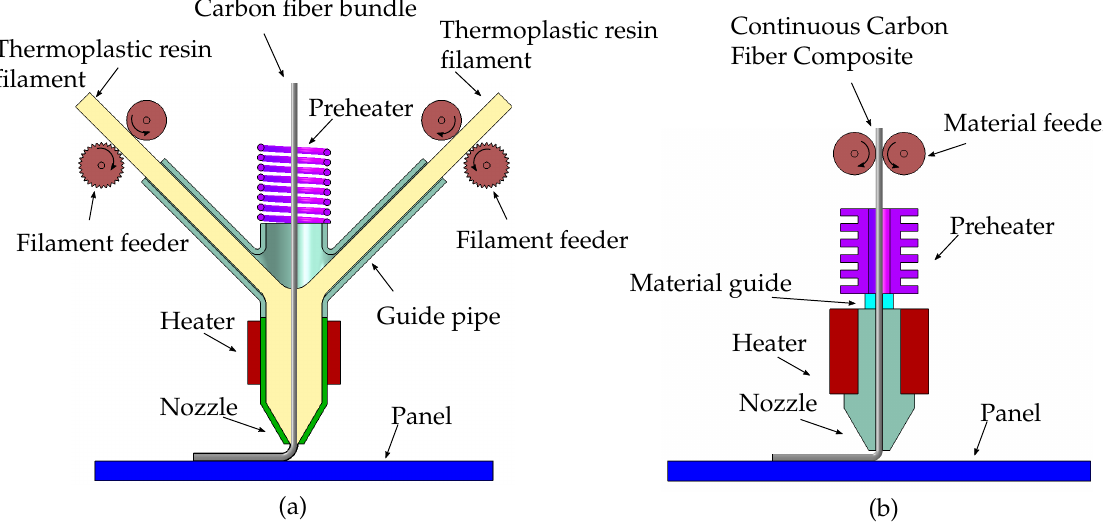
Figure 4. 3D printing with continuous carbon-fiber-reinforced plastics. ( a ) Multi filament; ( b ) Single